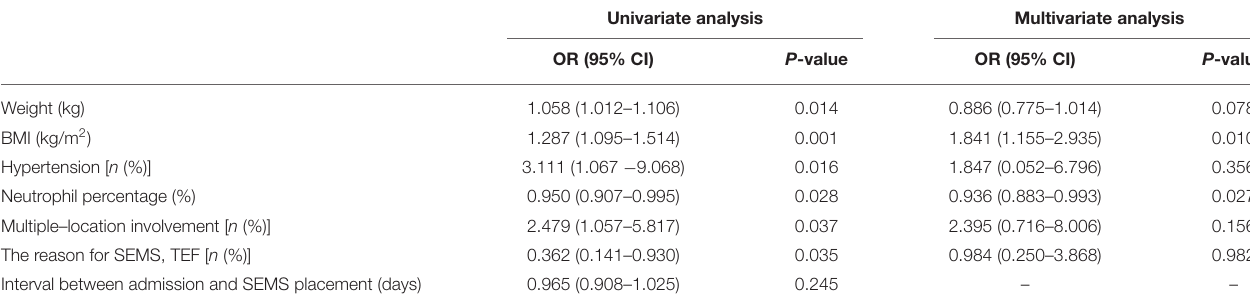
TABLE 5 | Univariate and multivariate analyses of potential risk factors for the survival in malignant airway diseases at 3 months after SEMS placement. Univariate analysis Multivariate analysis OR (95% CI) P -value OR (95% CI) P